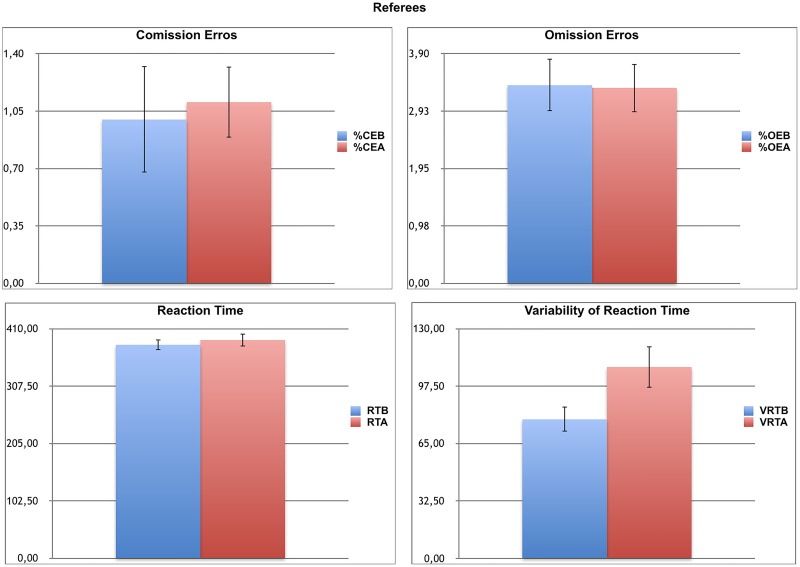
Attentional Performance of Soccer Referees before and after the physical fitness test. Note the significant increase in VRT after the FIFA-Test. %CE, percentage of commission errors; %CEB, percentage of commission errors before the FIFA-Test; %CEA, percentage of commission errors after the FIFA-Test; %OE, percentage of omission errors; %OEB, percentage of omission errors before the FIFA-Test; %OEA, percentage of omission errors after the FIFA-Test; RT, reaction time; RTB, reaction time before the FIFA-Test; RTA, reaction time after the FIFA-Test; VRT, variability of reaction time; VRTB, variability of reaction time before FIFA-Test; VRTA, variability of reaction time after the FIFA-Test; CVAT, Computer Visual Attention Test. Data are expressed as means and each bar is the respective standard error of the mean.